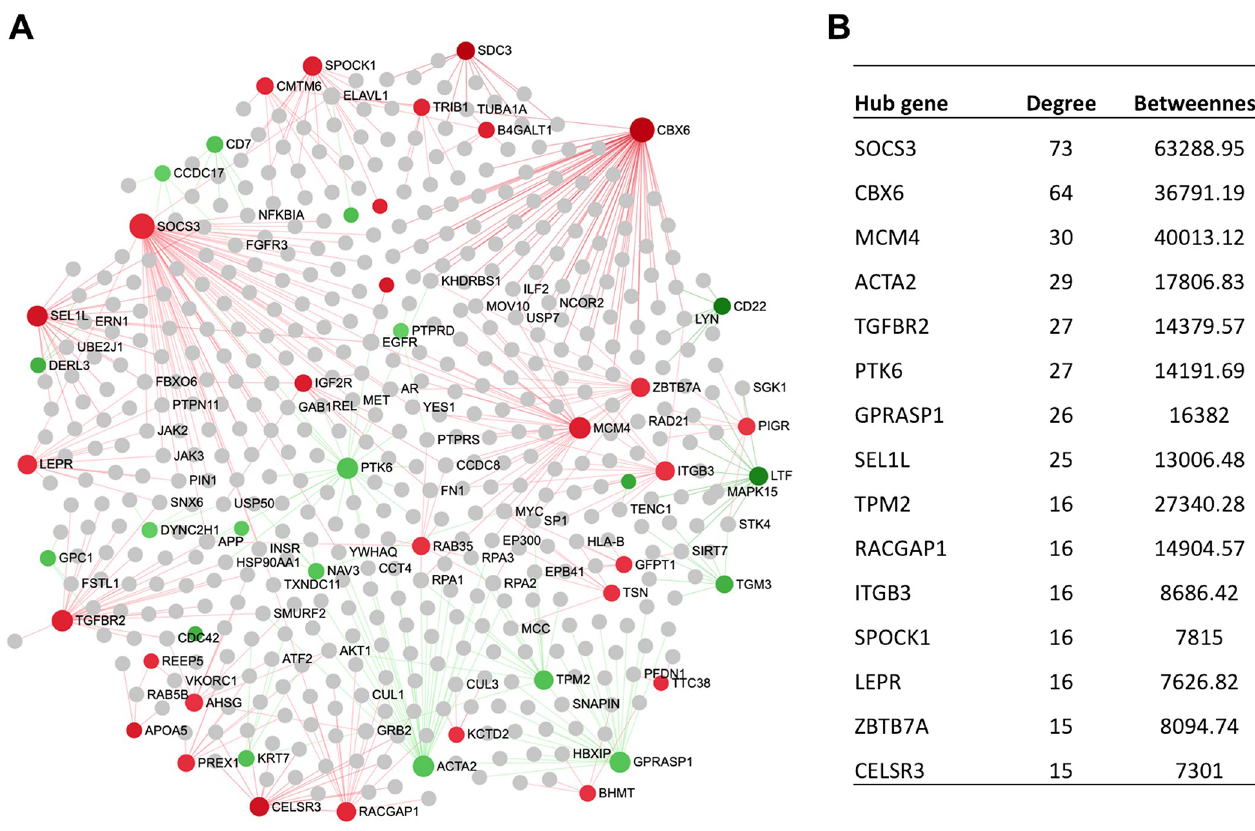
Fig 5. The liver-specific PPI network generated from the DEGs.